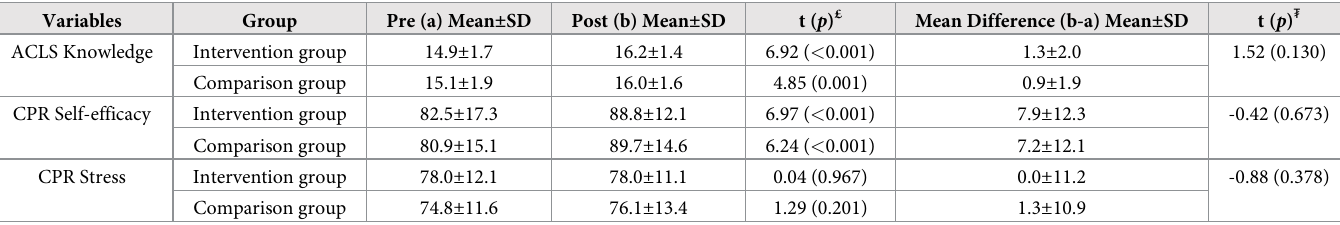
Table 3. Comparison within and between group about knowledge, self-efficacy, and stress (N =